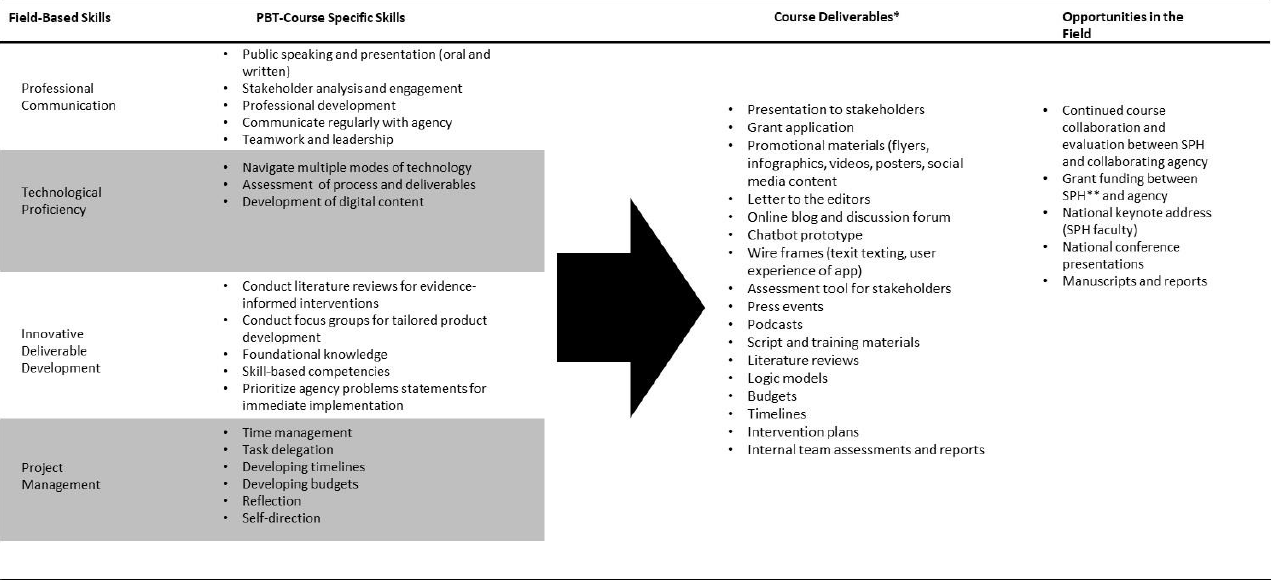
Figure 2. Outcomes of a Practice-Based Teaching (PBT) Course — Student Skill Acquisition, Collaborating Agency Deliverables, and Public Health Impacts.